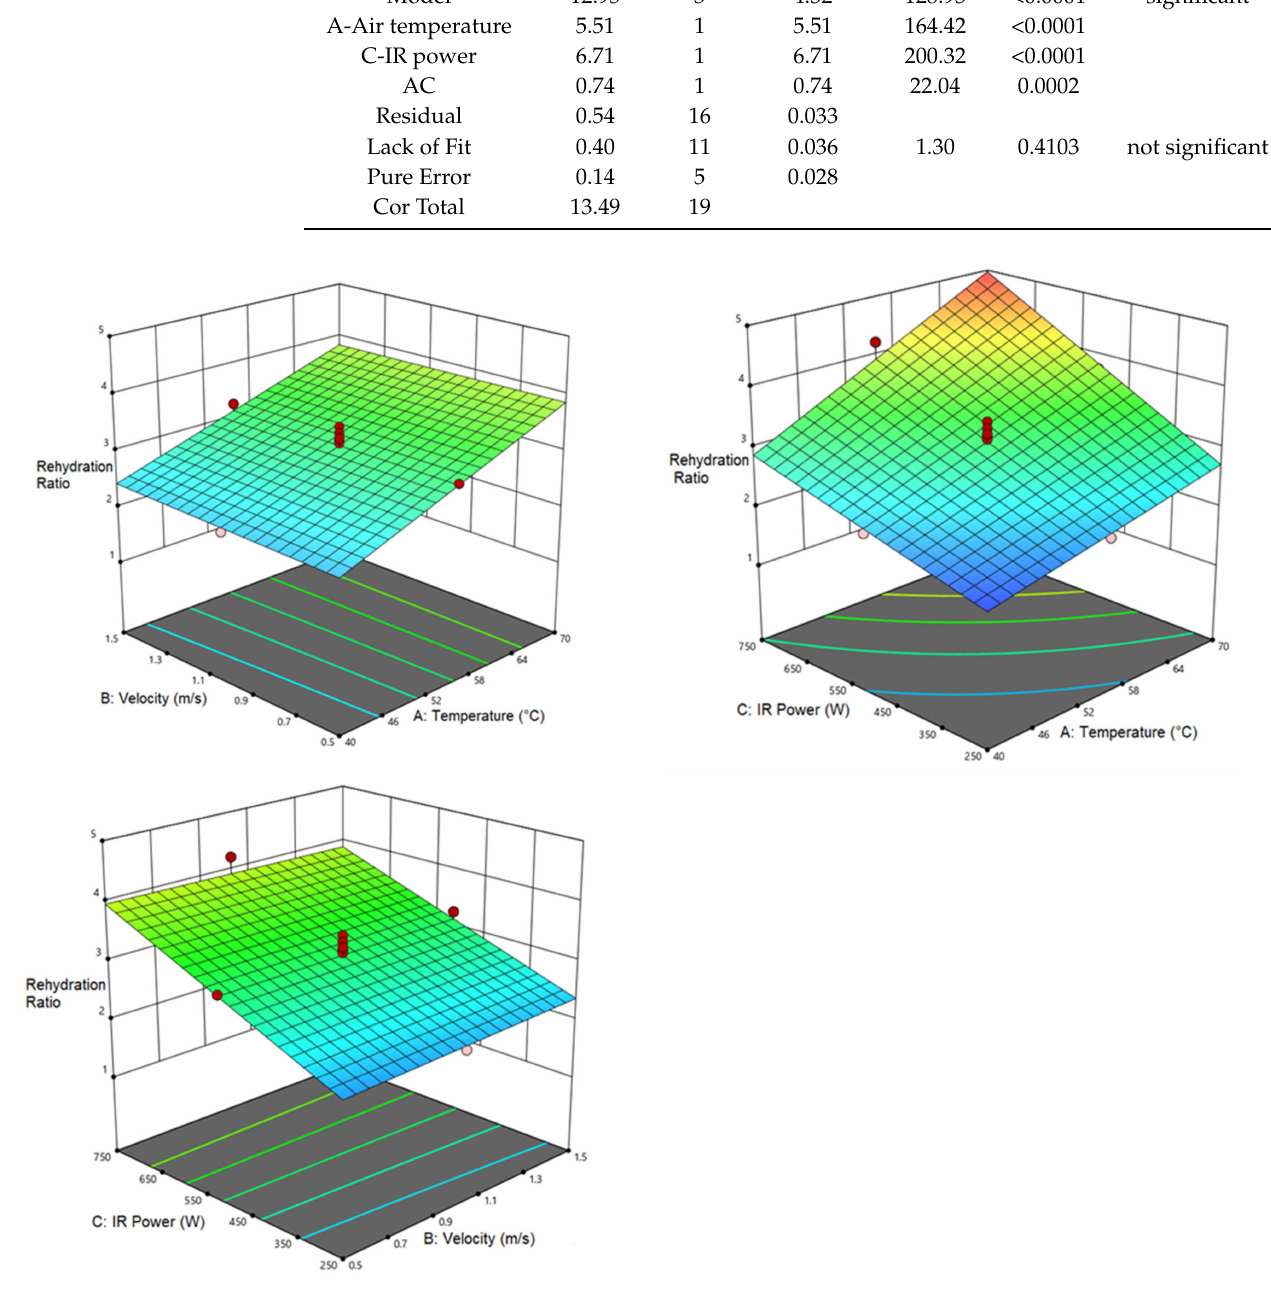
Figure 5. Interaction of air temperature/air velocity, air temperature/IR power, and IR power/air velocity on rehydration ratio of